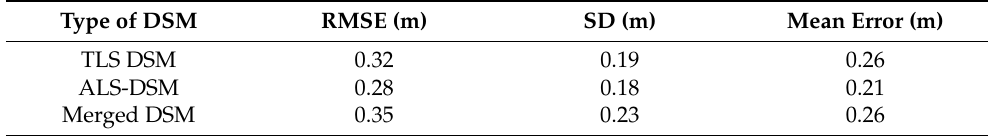
Table 1. Accuracy analysis of the DSMs used for the Tavoliere delle Puglie; for the different DSMs, root mean square error (RMSE), standard deviation (SD), and mean error were assessed. Type of DSM RMSE (m) SD (m) Mean Error (m) TLS DSM 0.32 0.19 0.26 ALS-DSM 0.28 0.18 0.21 Merged DSM 0.35 0.23